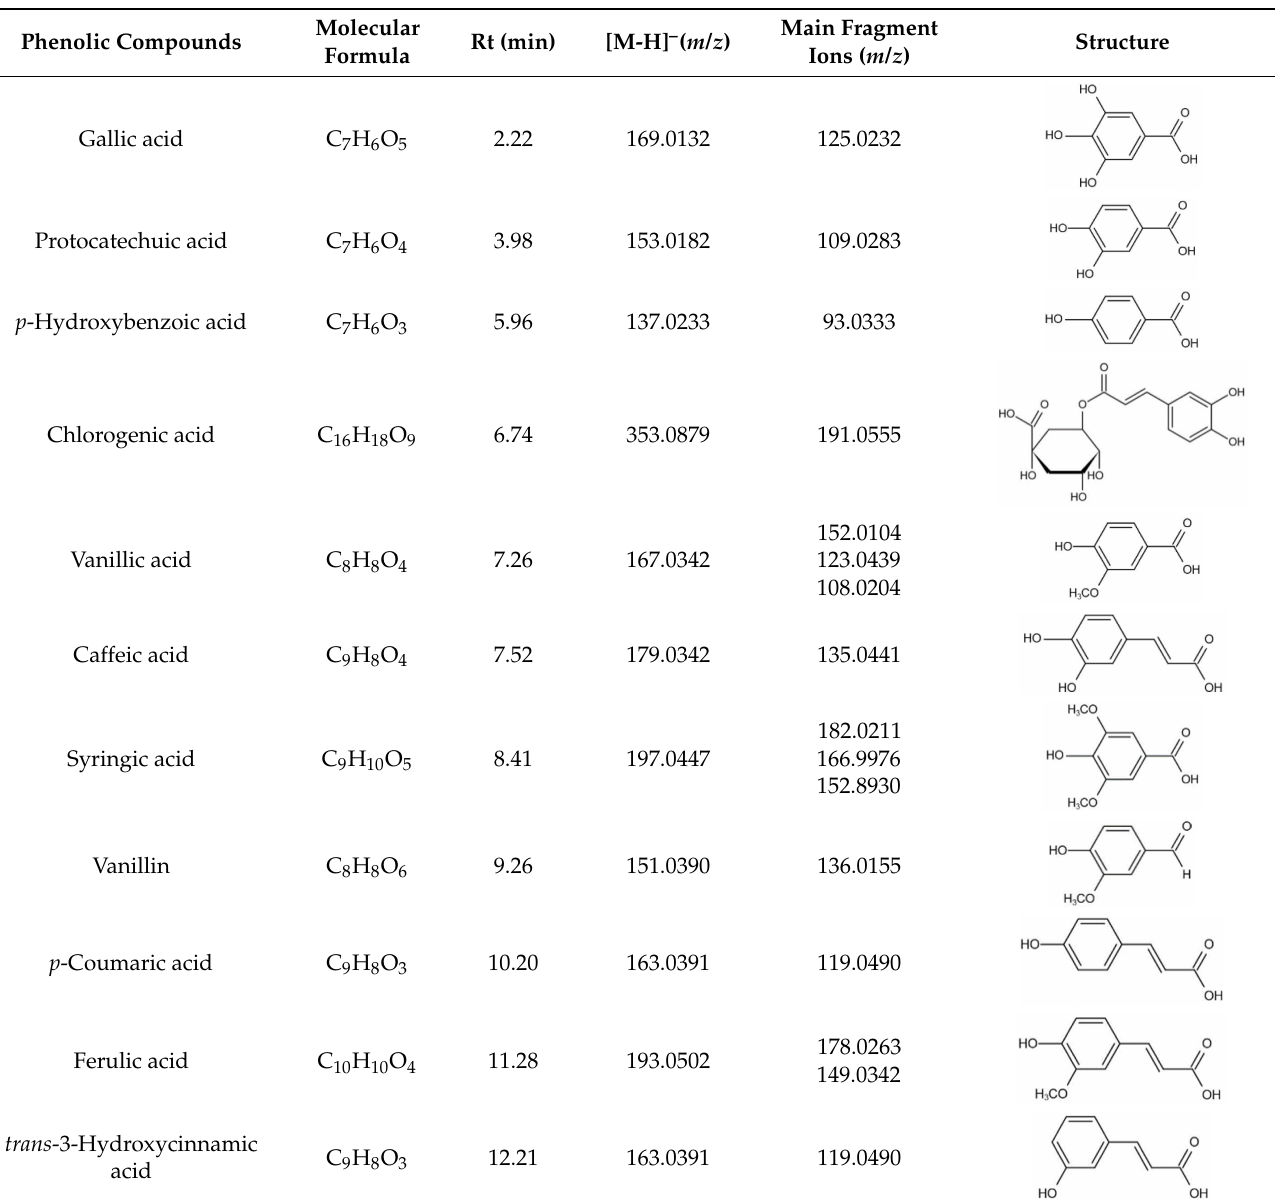
Table 1. Identification of main phenolic compounds in brown rice with structural